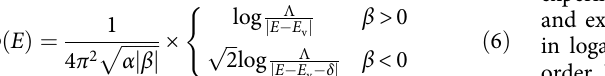
¼ α (cid:4) 1 . b Normalized 0 ¼ 0